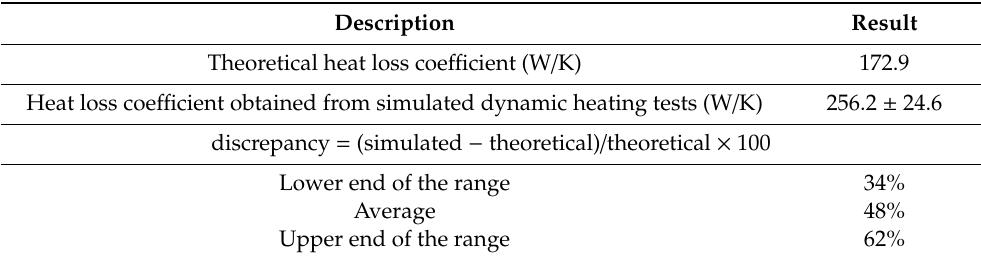
Table 5. Comparison of theoretical heat loss coe ffi cients and those measured with physical dynamic heating